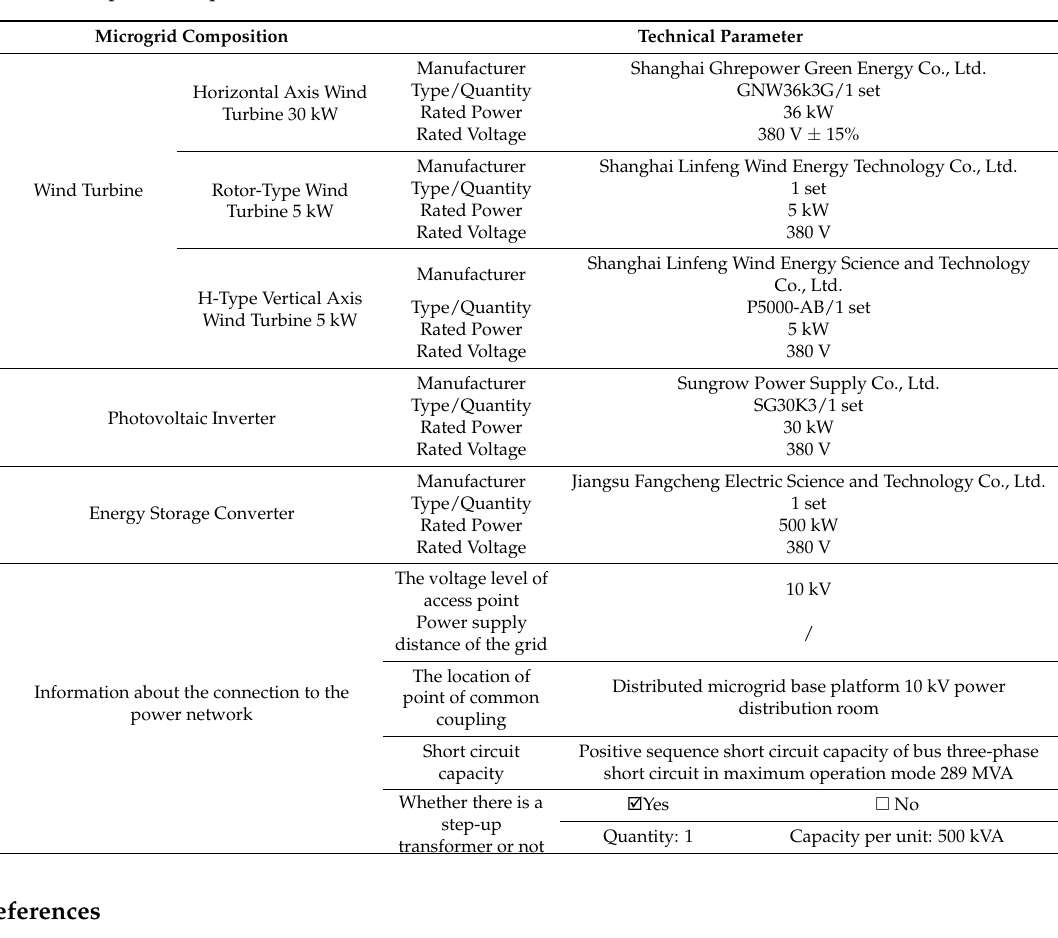
Table A1. Basic information of the microgrid of Electric Power Research Institute of State Grid Jiangsu Electric power corporation.